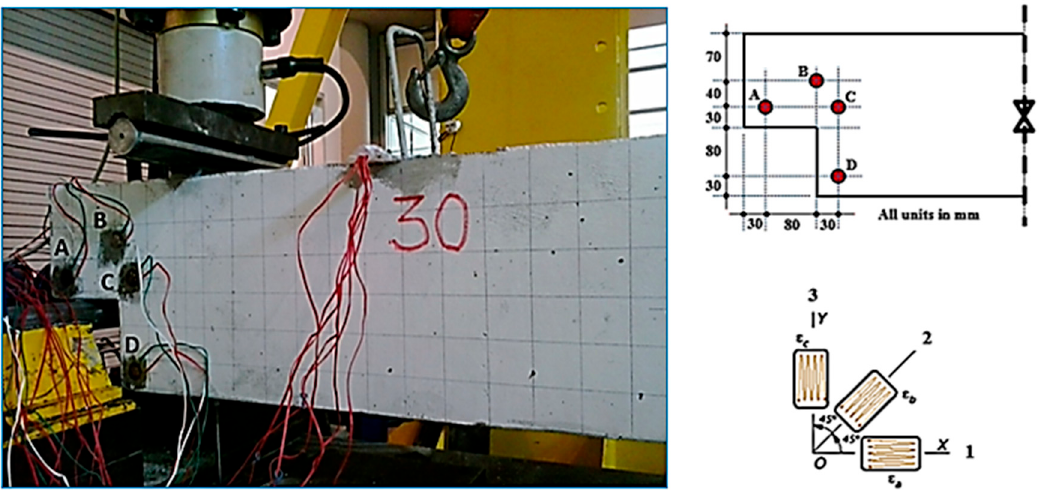
Figure 3. Placement scheme of Rosette Strain Gages (RSGs, (A, B, C, and D)) at dapped-end region.